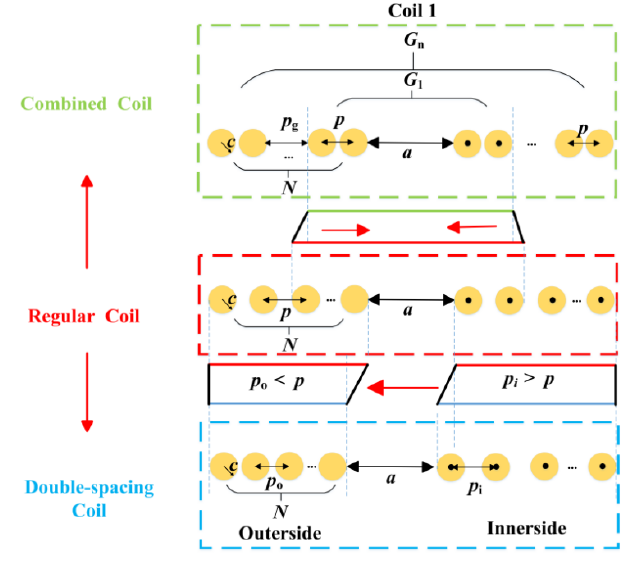
Figure 10. Structures of two improved DD coils.